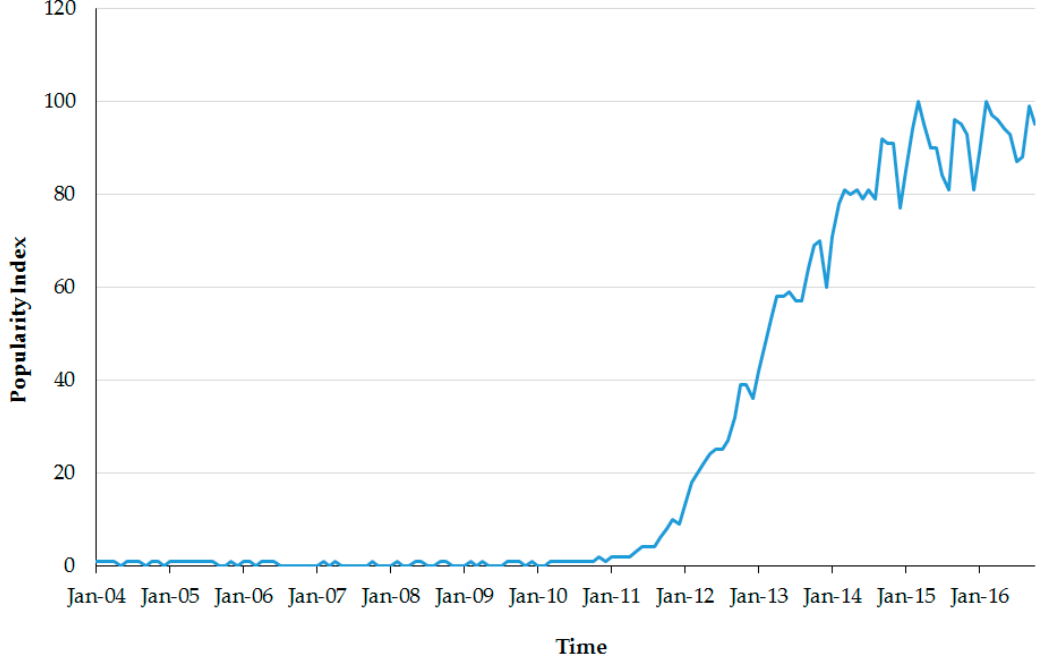
Figure 1. The popularity of the search query “Big Data” in Google Trends.